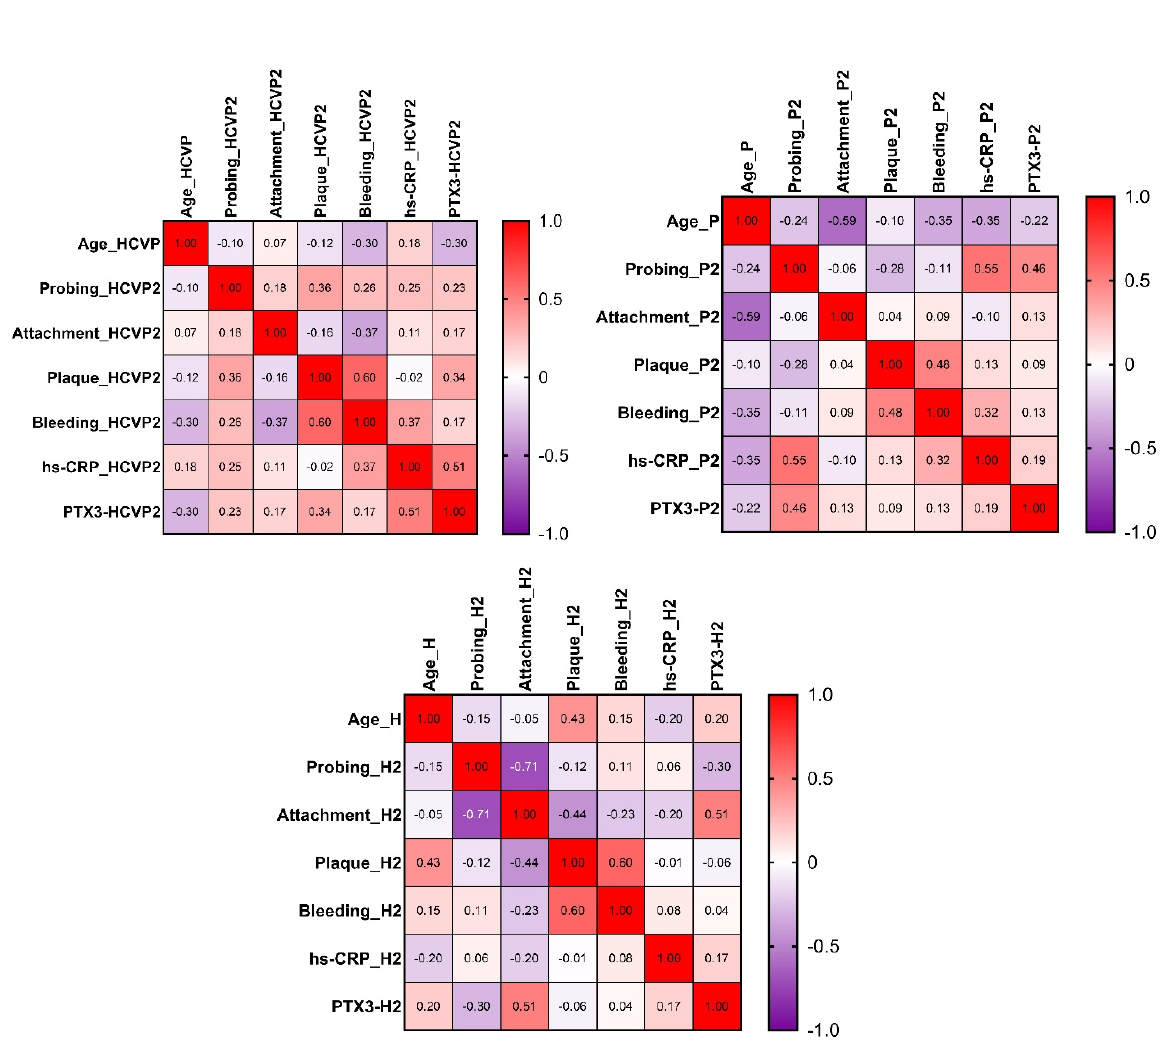
Figure 2. Heatmap of the correlation matrix for every group of patients after the treatment: HCVP2 = HCV+P group at recall; P2 = P group at recall; H2 = H group at recall.